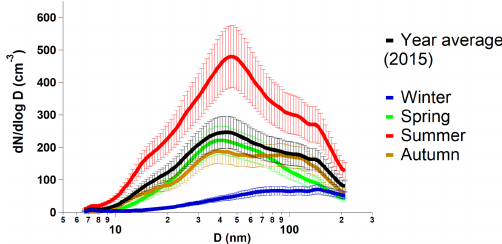
Figure 1. Seasonal mean aerosol size distribution measured by the SMPS at Halley VI over the year 2015. The error bars represent the standard deviation of the measurements from the mean value. D: diameter.